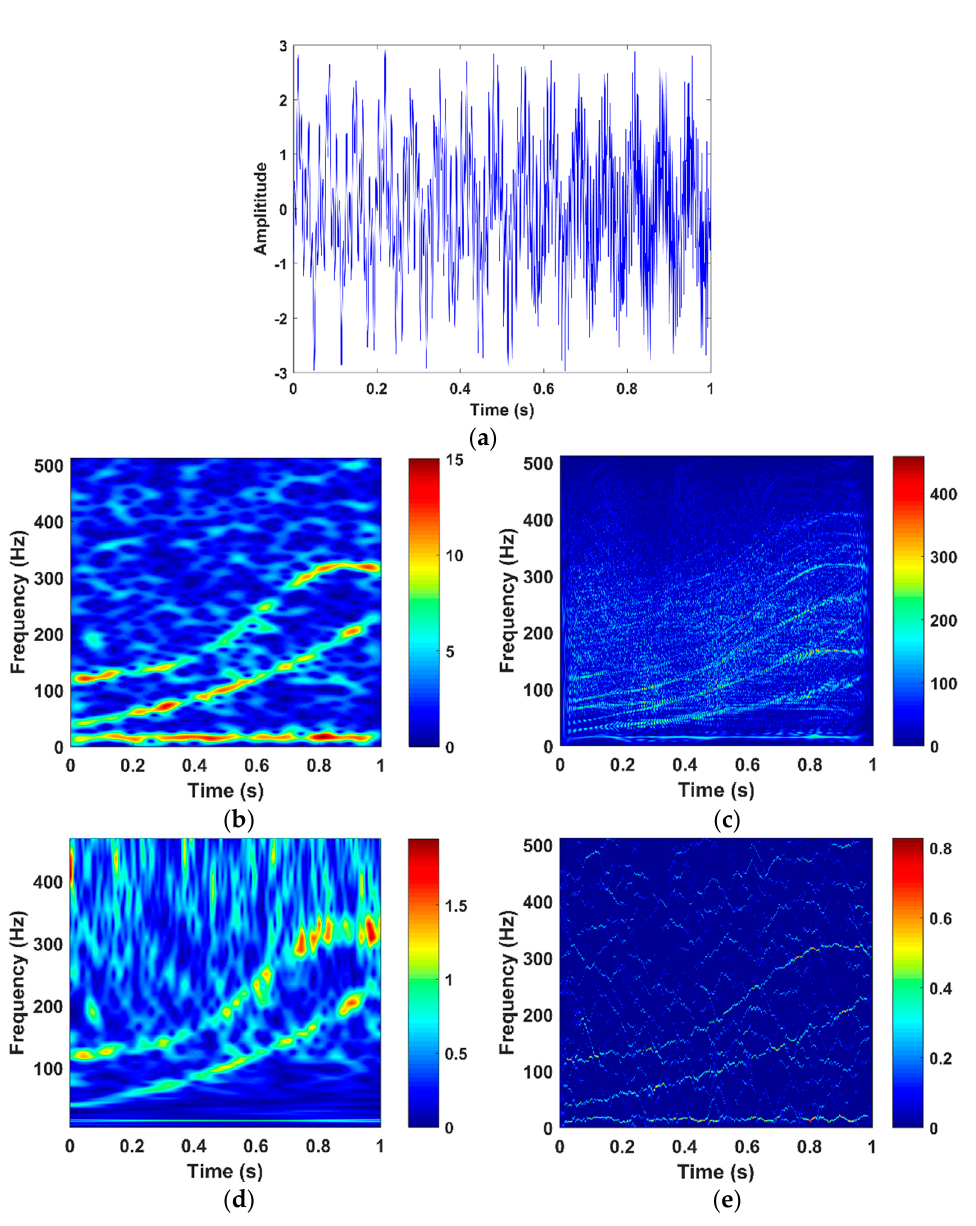
Figure 3. ( a ) Time-domain waveform of the noisy signal z ( t ) with the signal-to-noise ratio (SNR) of − 2 dB, and its TFIs obtained using ( b ) STFT, ( c ) PWVD, ( d ) WT, and ( e ) STFA-PD.